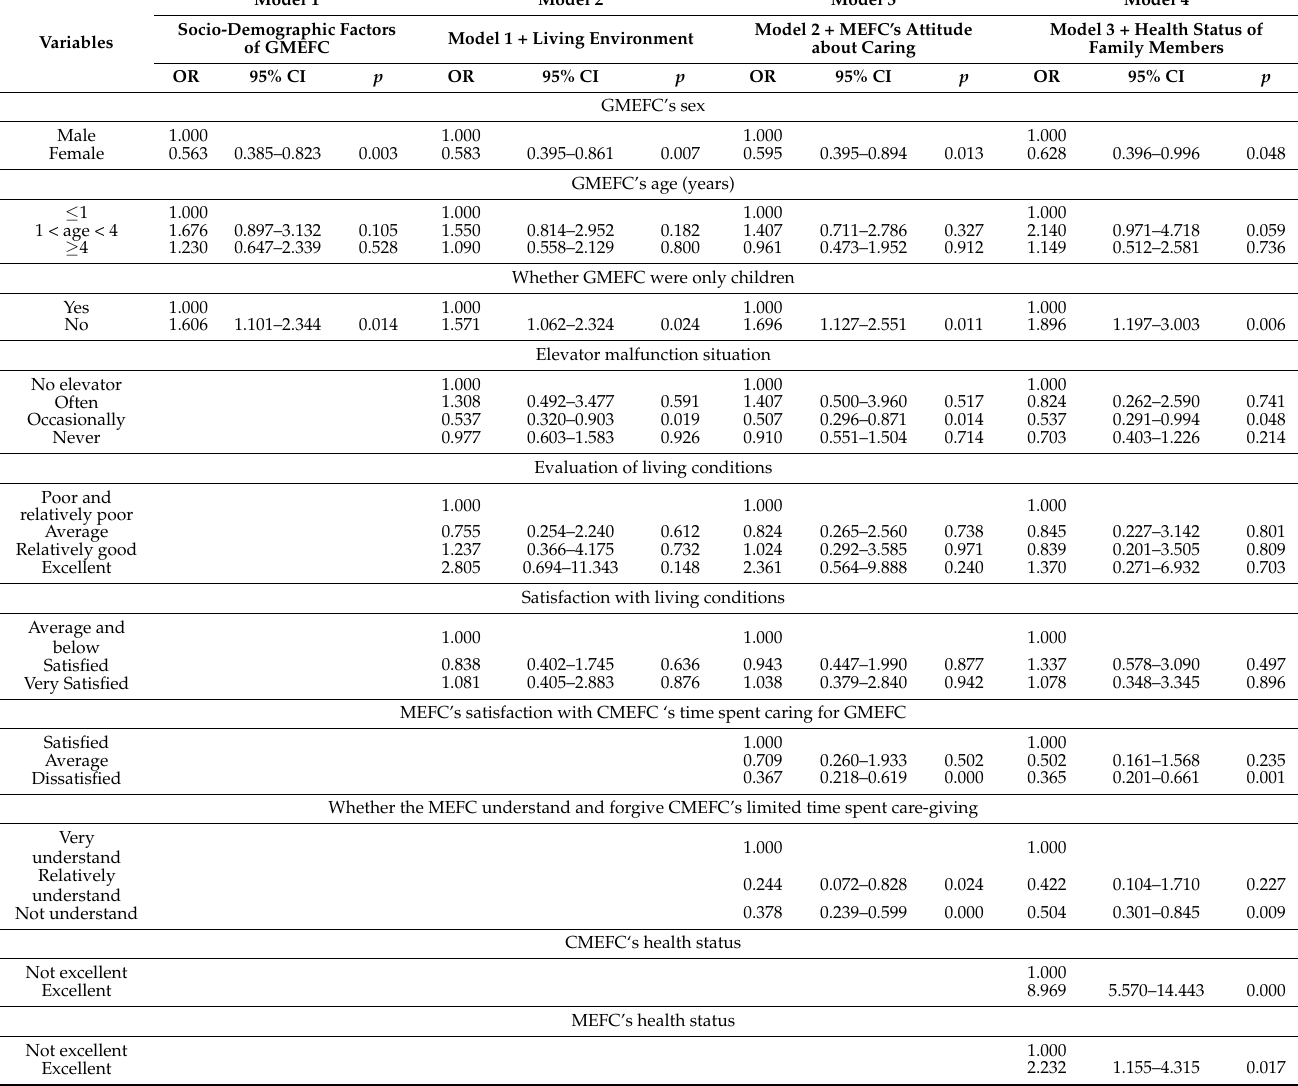
Table 2. Binary logistic regression for relationships between related variables and health status of